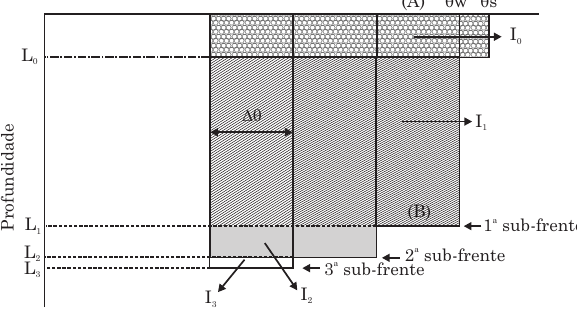
Figura 2. Perfil de umidade em um instante qualquer, após o